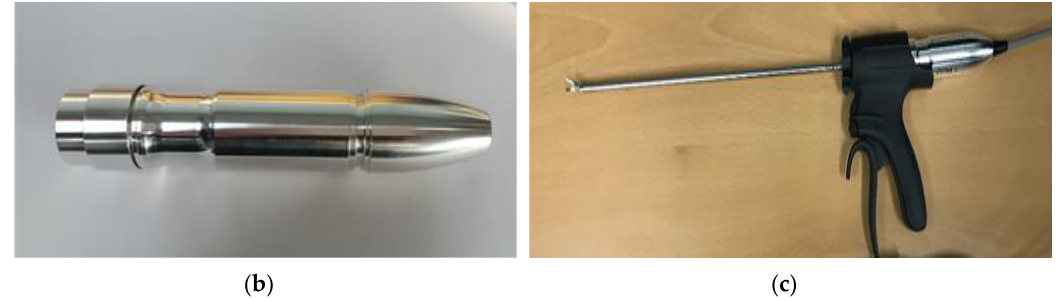
Figure 6. ( a ) 3D model and ( b ) assembled outer case part. ( c ) Assembled BLUT, waveguide, and handheld instrument.